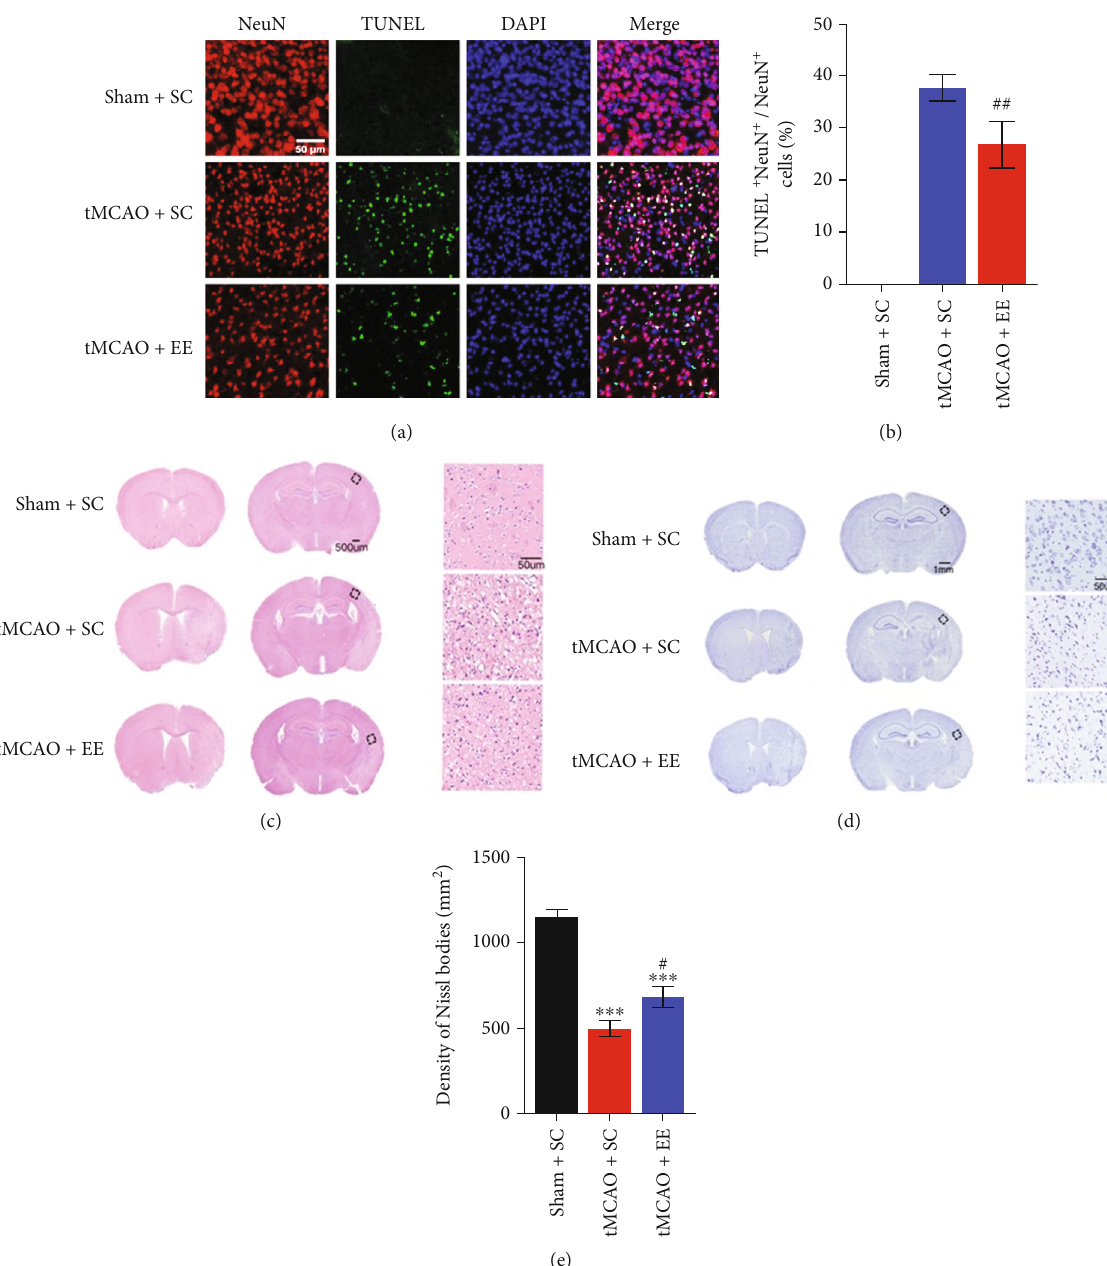
Figure 2: (a) TUNEL and NeuN staining results. (b) Comparison of apoptotic neurons in total neurons (apoptotic neurons in sham+SC group were not a part of the comparative study). (c) Hematoxylin and eosin staining results. (d) Cresyl violet staining results. The framed area is the ischemic penumbra. (e) Comparison of the density of cresyl violet bodies; ∗∗∗ P < 0 : 001 vs . sham+SC group; # P < 0 : 05 and ## P < 0 : 01 vs . tMCAO+SC